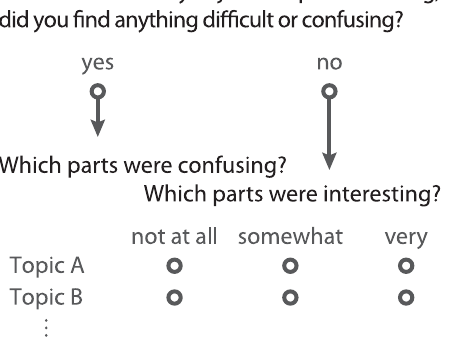
FIG. 1. Before class, students are asked to respond to this three- part confusion question regarding the reading material that they just completed as part of a reading assignment. The second part differs depending on whether students respond yes or no in the first part, as shown. The third part is free